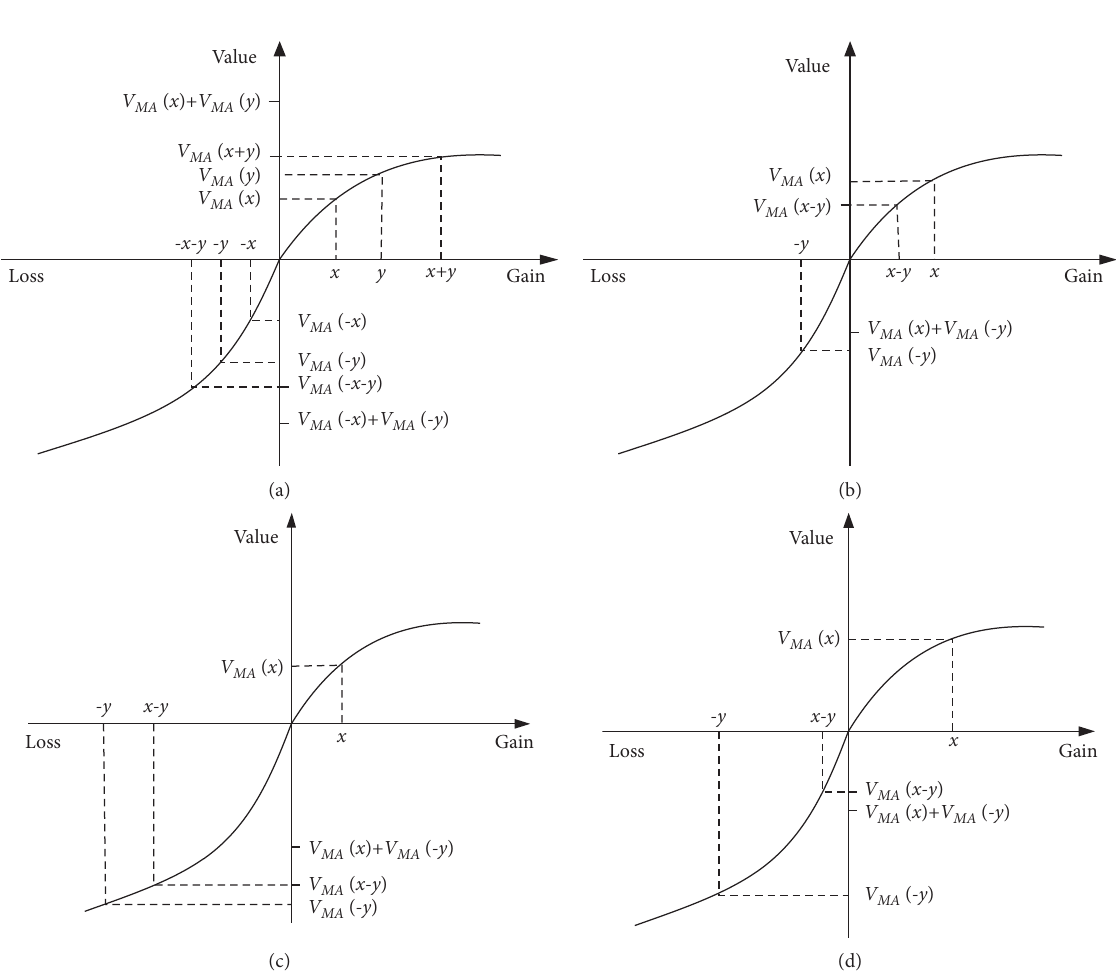
Figure 3: Value function of mental accounting theory. (a) Both outcomes are gains or losses. (b) One is gain and the other is loss (gain is greater than loss). (c) One is gain and the other is loss (gain is much less than the loss). (d) One is gain and the other is loss (gain is slightly less than the